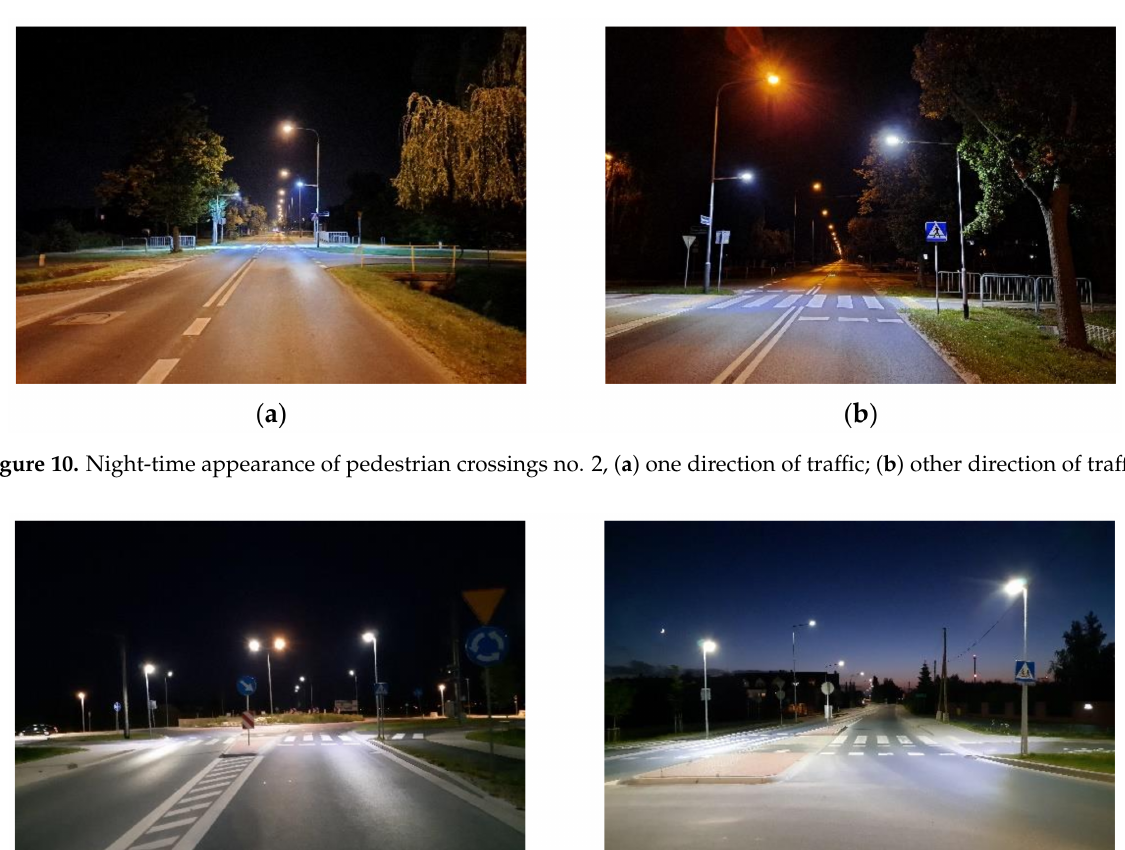
Figure 9. Night-time appearance of pedestrian crossings no. 1.